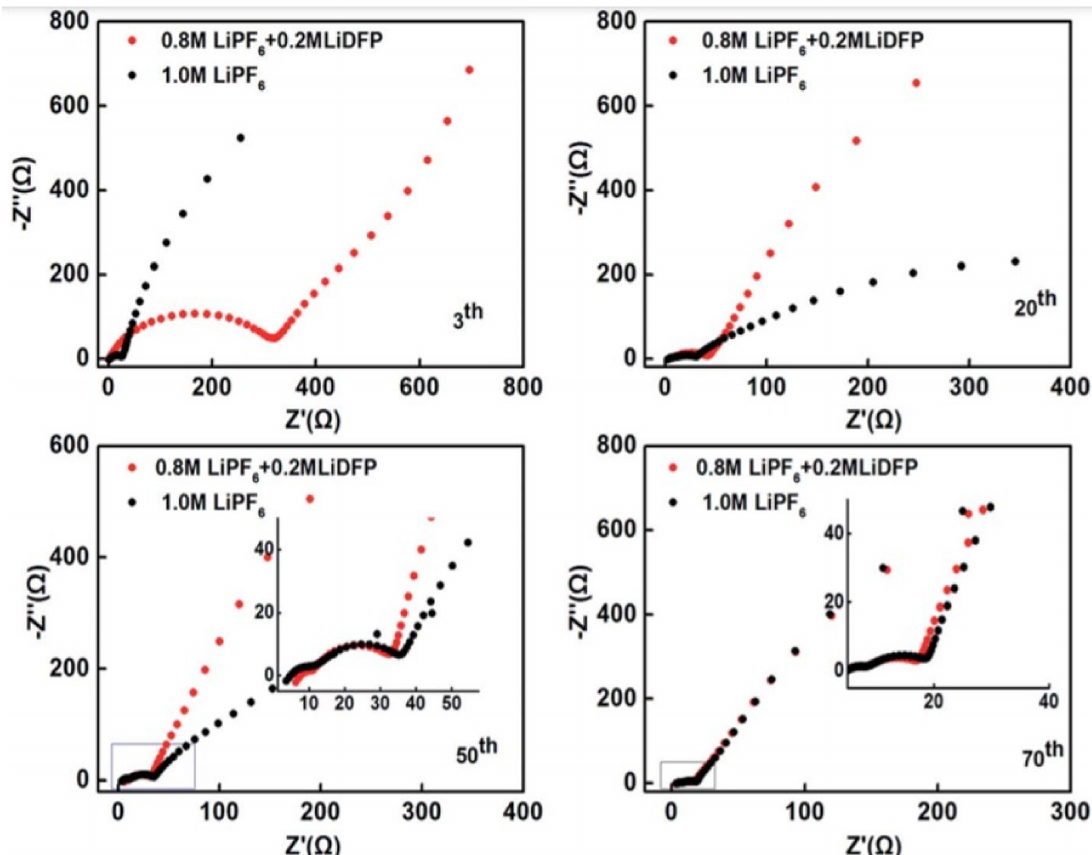
Figure 26. Electrochemical impedance analysis of Li anode LiDFP/LiPF 6 dual salt electrolyte (adapted with permission from [258] RSC Adv.,